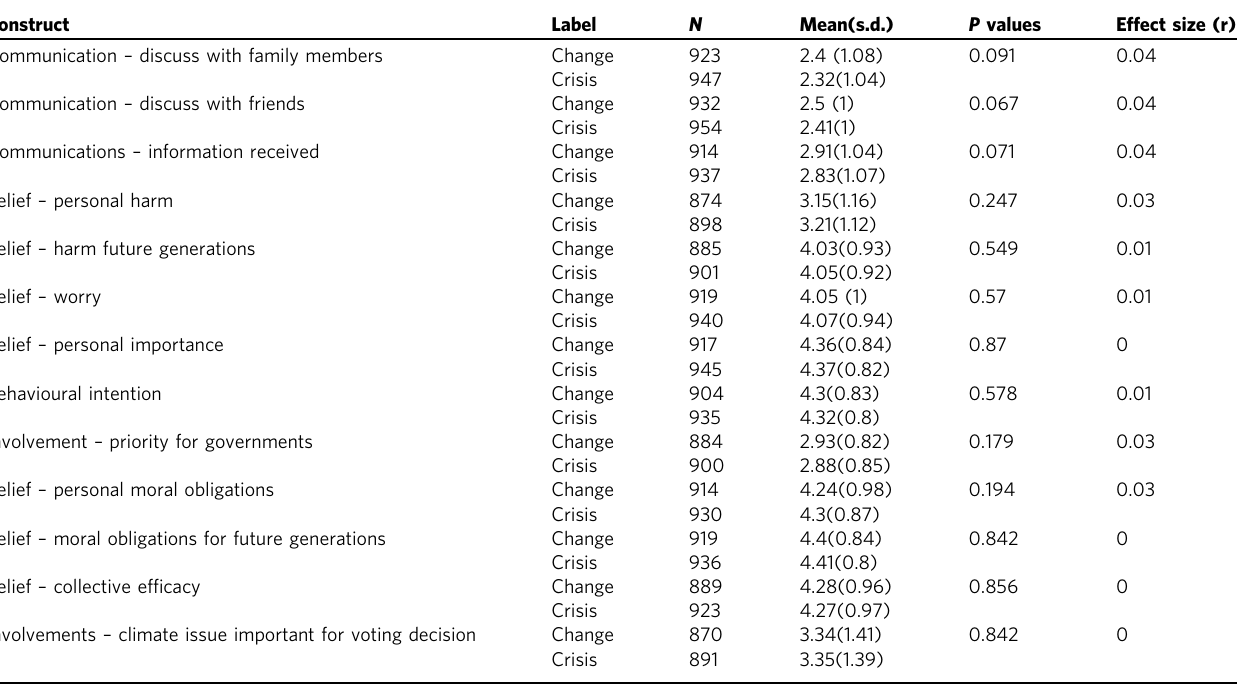
Table 1 Two-sided independent sample t- test results of labelling effects for the whole sample. Construct